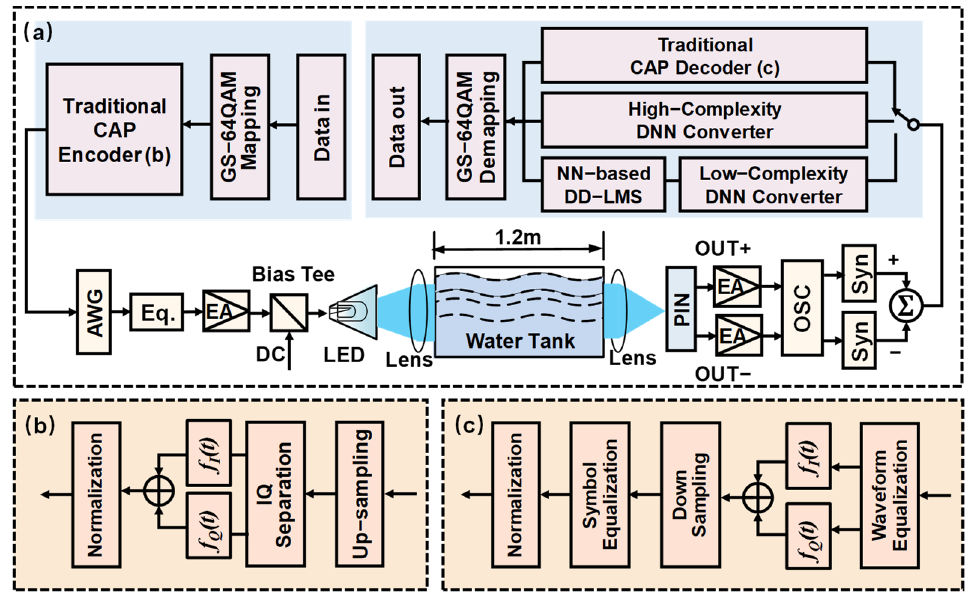
Figure 2. Experimental setup of Underwater VLC system using different receivers. ( a ) shows the overall setup of UVLC system in our experiments. ( b ) shows the details of traditional CAP en- coder at the transmitting end. ( c ) shows the details of traditional CAP decoder at the receiving